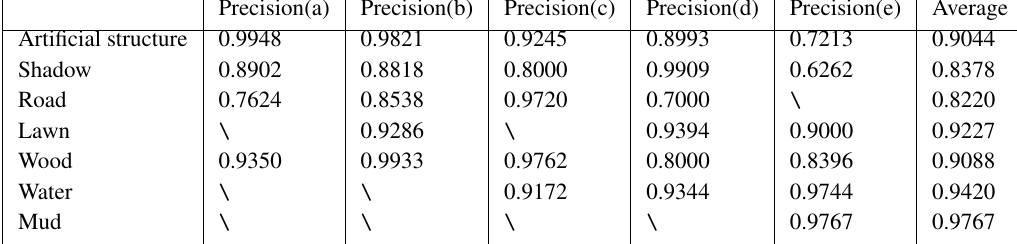
Table 1. The evaluation results of